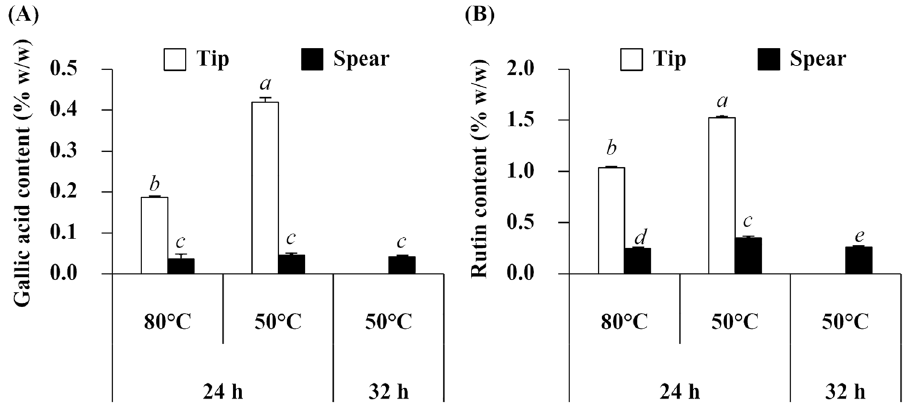
Figure 3. Gallic acid content ( A ) and rutin content ( B ) of A. officinalis extracts prepared at different drying temperatures and drying duration. Different letters, a, b, c, d, and e, denote significant differences in rutin content among various A. officinalis extracts, whereas similar letters denote non-significant differences at p < 0.05.